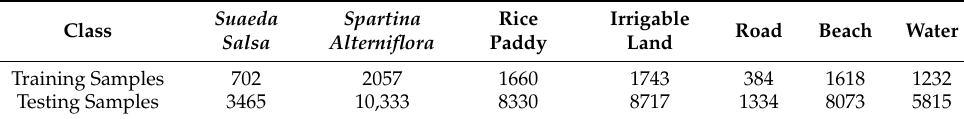
Table 1. Sample points